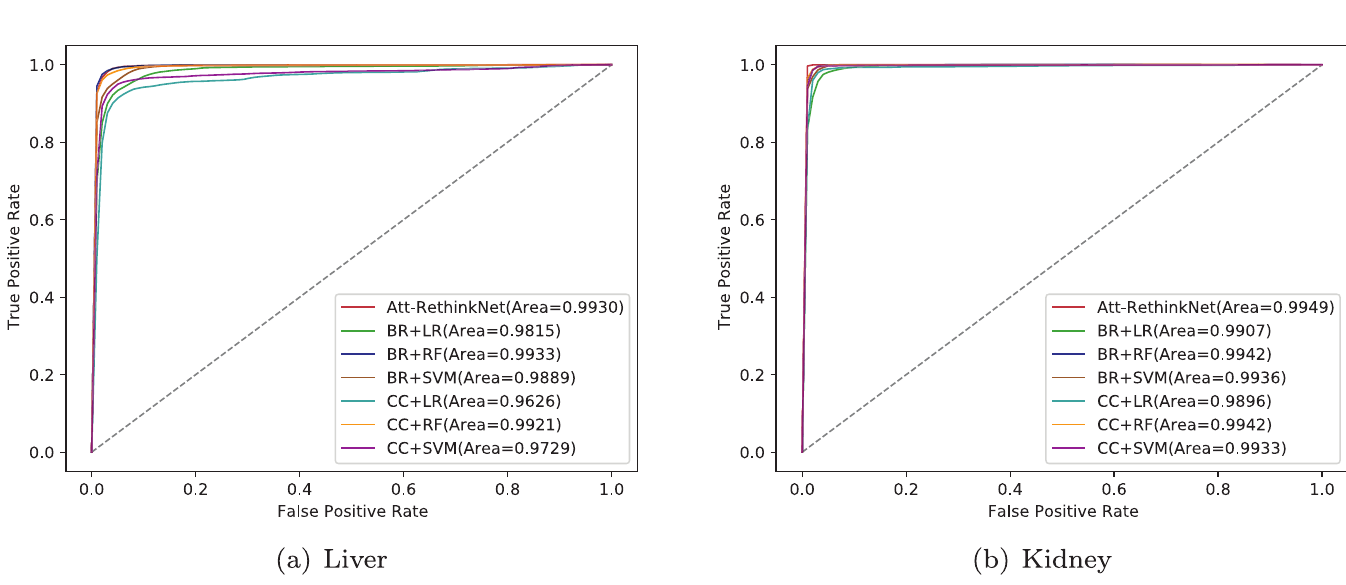
1 CLF represents classifier and PF means pathological finding. 2